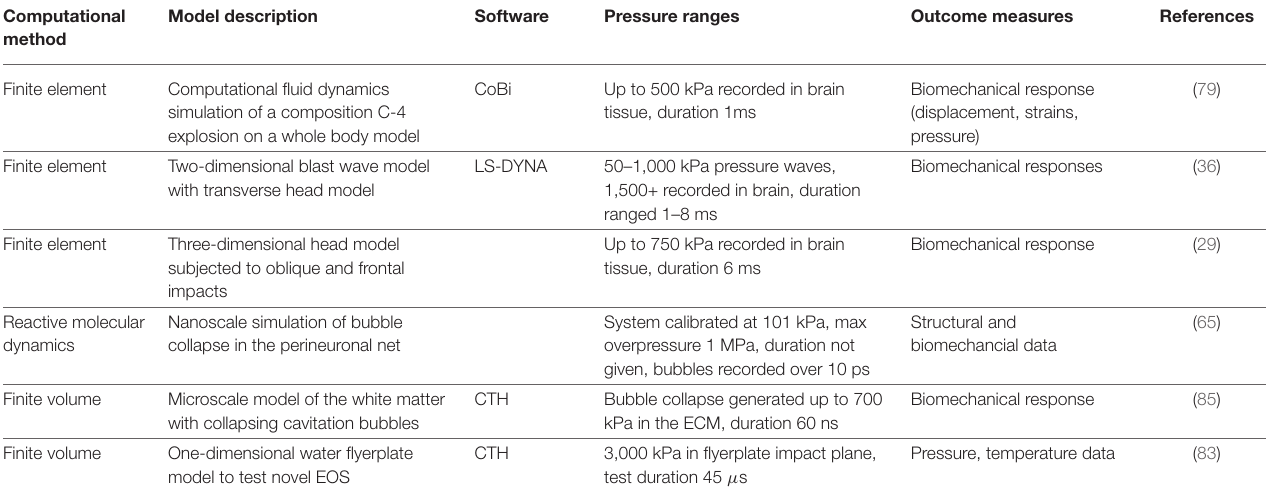
TABLE 2 | A summary of simulations modeling